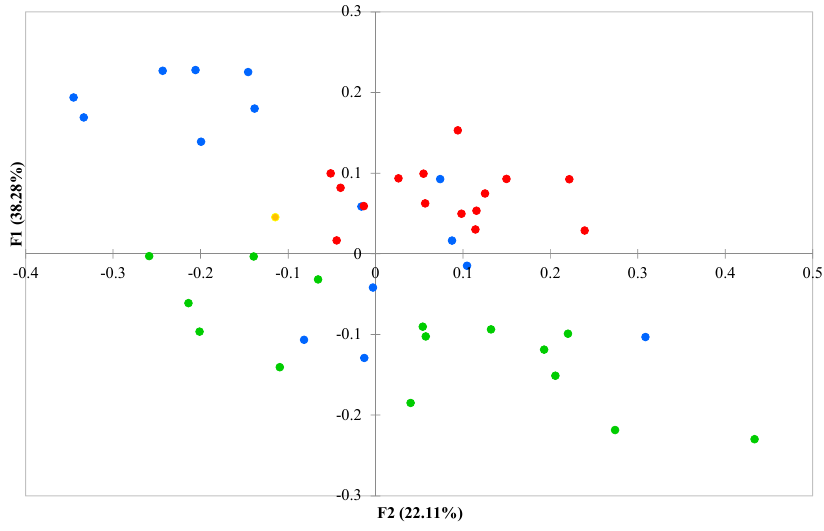
Figure 4. Agglomeration (Ward method; Dice coefficient) analysis of the R, PSE, DSE and TSE sets of regenerates based on AFLP and metAFLP markers. Cluster significance (dotted line) determined on the basis of pseudo-F statistics with significance level p < 0.05 (R—donor plant; PSE—somatic embryos obtained through indirect somatic embryogenesis; DSE—secondary somatic embryos in- duced on the hypocotyls of PSE; and TSE—somatic embryos obtained through direct somatic em- bryogenesis from DSE).